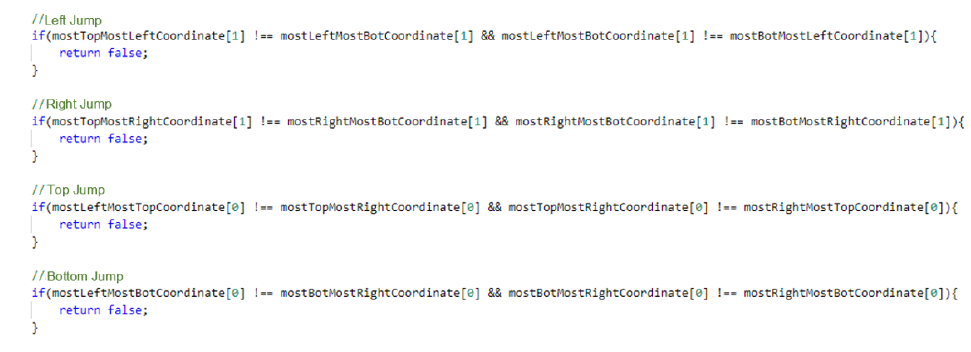
Figure 13. Pseudo-code for examining external jumps.